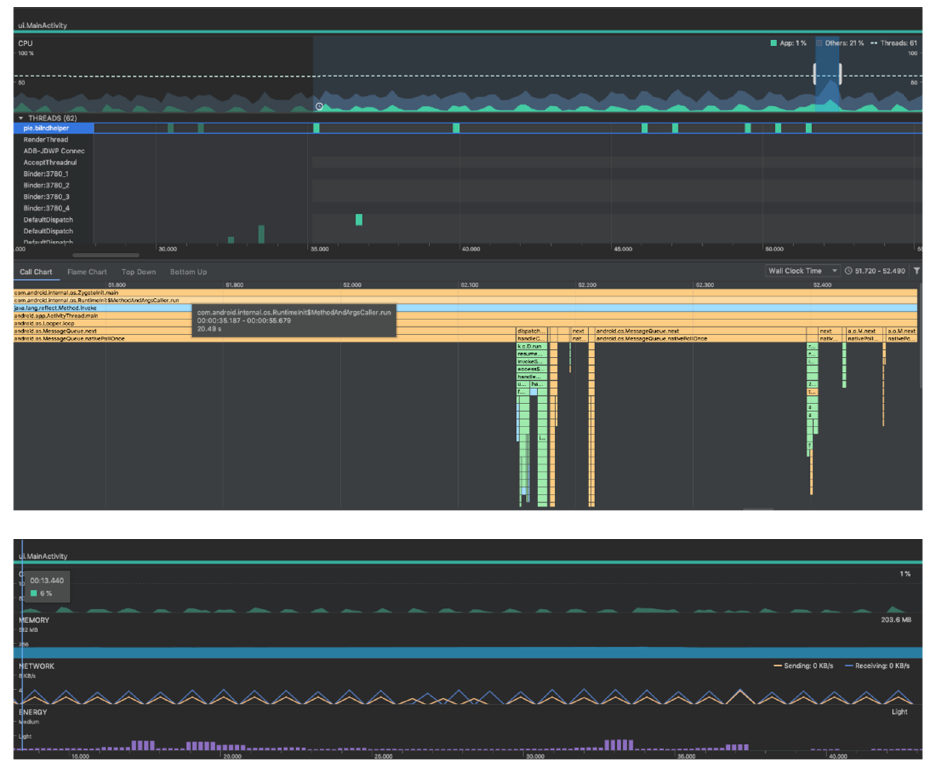
Figure 16. 6 × 6 Kalman filter CPU, memory and power load.